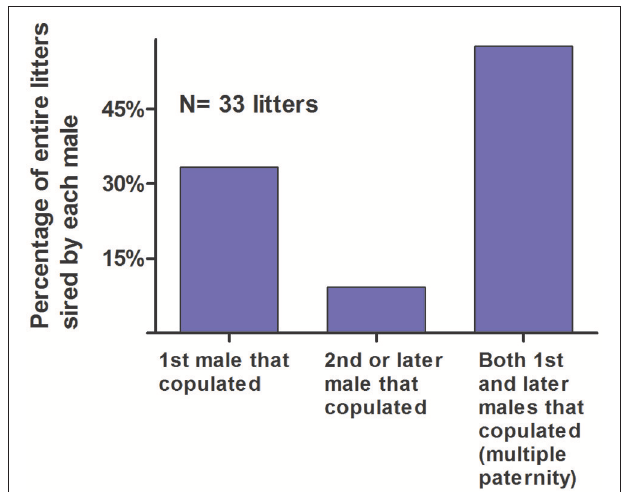
FIGURE 11 | Probability of siring an entire litter vs. order of copulation with the mother. These data are from likelihood of paternity analyses (LOP) from seven polymorphic microsatellites for male white-tailed prairie dogs at the Arapaho National Wildlife Refuge, Colorado USA, from 2006 through 2012. Of the 135 juveniles weaned by polyandrous females, the 1st-copulating had a higher LOP than 2nd- and later- copulating males for 86 (64%).